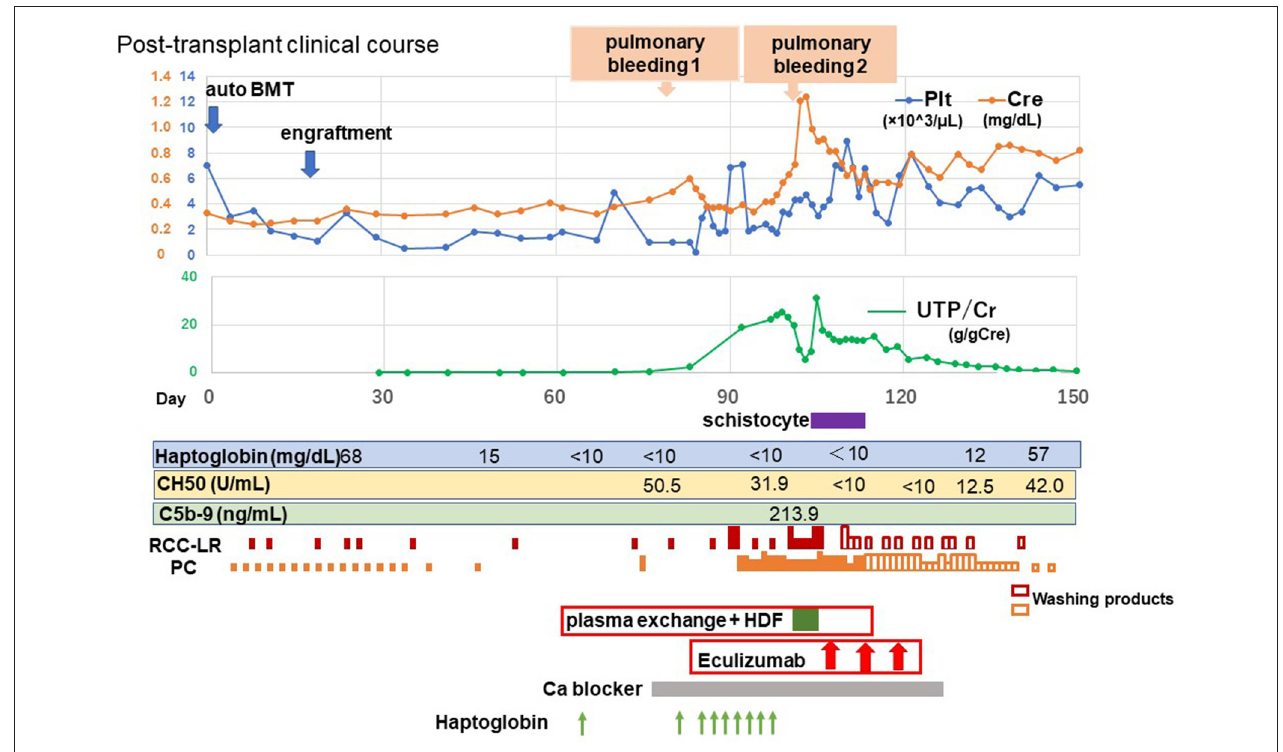
FIGURE 1 | Post-transplant clinical course. Platelet count, serum creatinine level, urine protein-creatinine ratio, haptoglobin, and complement titers are also shown to illustrate changes in transplant-associated thrombotic microangiopathy disease status. BMT, Bone marrow transplantation; Plt, blood platelet; Cr, creatinine; U-TP/Cre, urine protein-to-creatinine ratio; CH50, 50% hemolytic unit of complement; C5b-9, membrane attack complex; HDF, hemodiafiltration; RCC-LR, red cell concentrates-leukocytes reduced; PC, platelet concentrate; Ca,